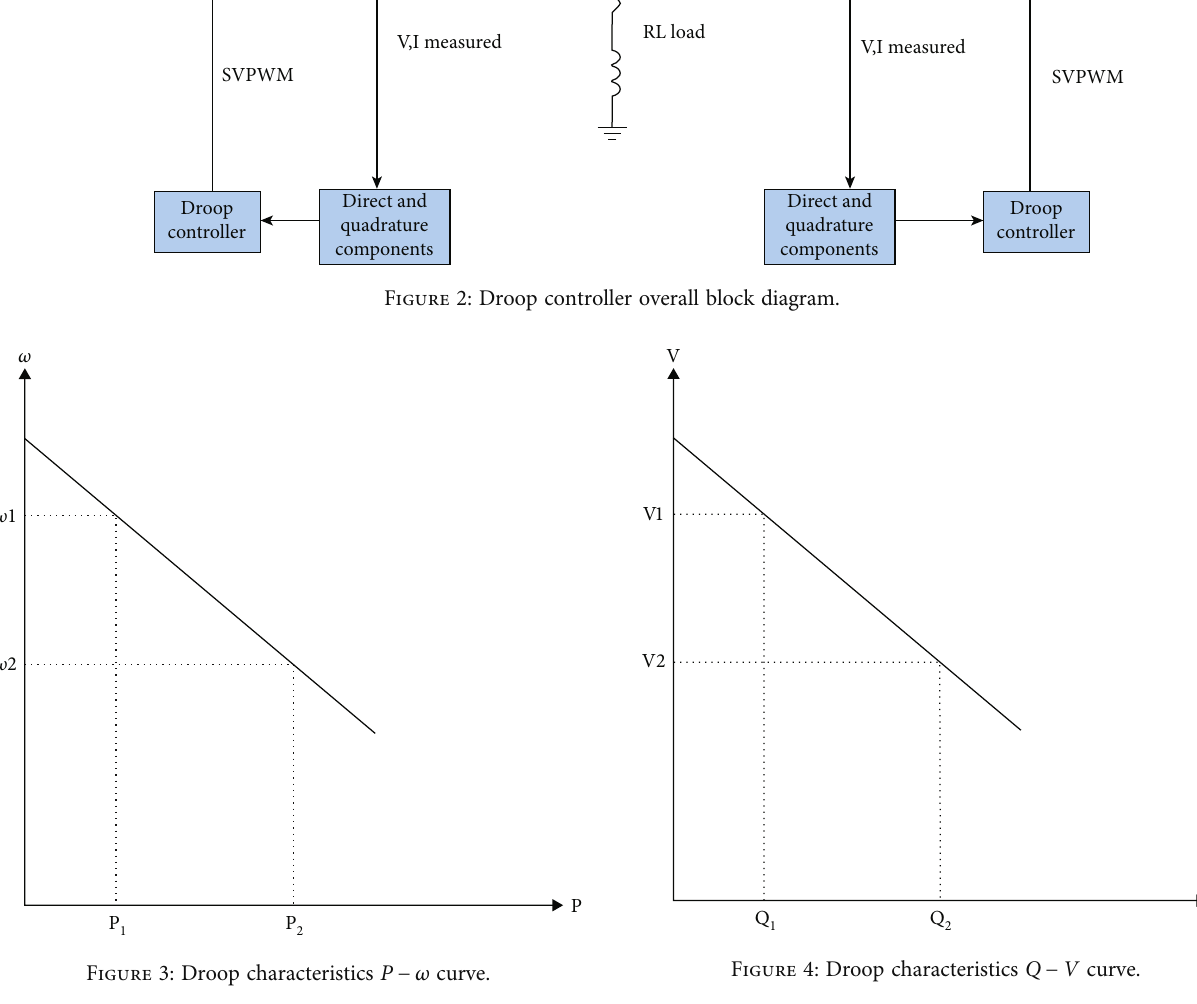
Figure 3: Droop characteristics P − ω curve. Figure 4: Droop characteristics Q − V